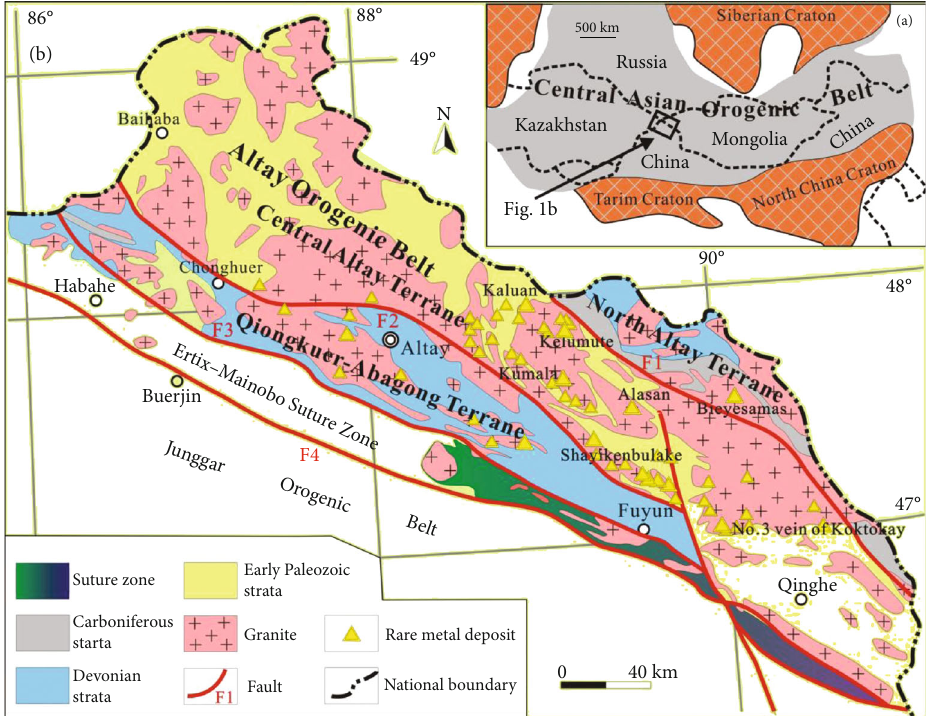
Figure 1: Geotectonic position (a) and distribution of intrusive rocks (b) in the Altay area of Xinjiang, Northwestern China. Main faults: F1, Hongshanzui Fault; F2, Abagong Fault; F3, Kezijiaer Fault; F4, Ertix